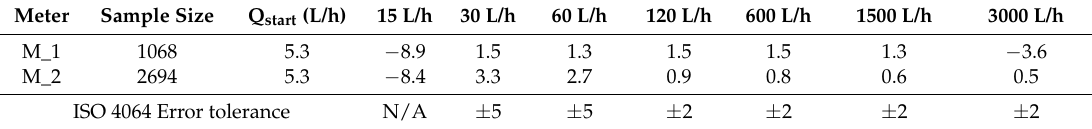
Table 2. The average starting flow rate and error tolerance (%) of indication for each meter